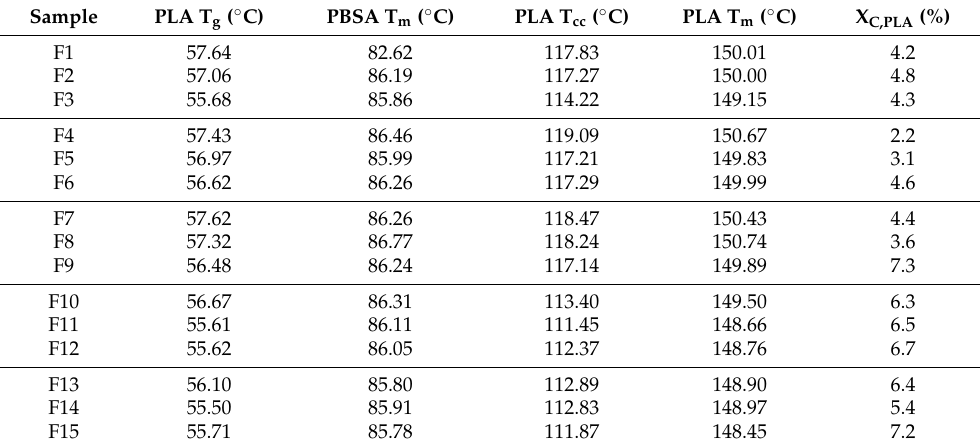
Table 4. Identification of the main transition temperatures and crystallinity.